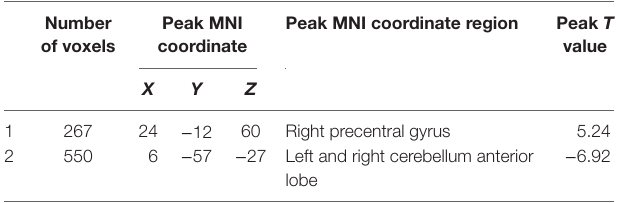
TaBle 3 | Significant ALFF difference between baseline and 3 months after treatment with their location. number Peak Mni Peak Mni coordinate region Peak T of voxels coordinate